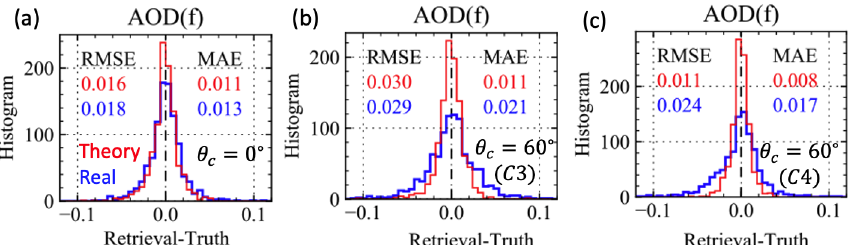
Figure 5. The histogram of the AirHARP retrieval errors for the fine-mode AOD from theoretical and real uncertainty estimations based on the MCEP method. (a) For the case without any correlation in the uncertainty; (b) for the cases with correlation only in the synthetic data (C3) and (c) also in the retrieval cost function (C4) with a correlation angle of θ c = 60 ◦ . Both mean average error (MAE) and root mean square error (RMSE) are computed for the theoretical and real errors indicated in red and blue text, respectively.